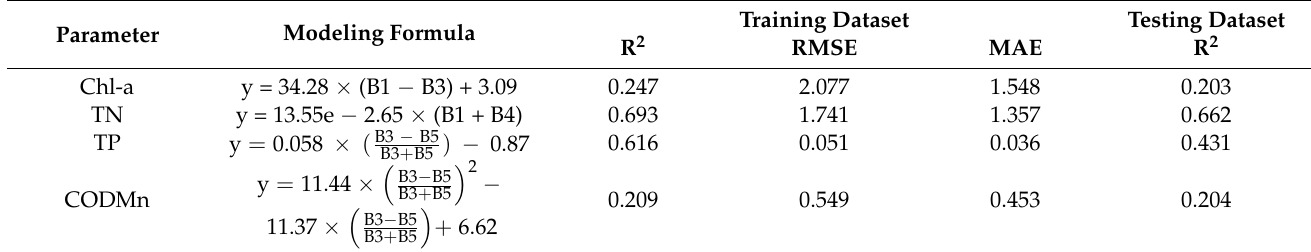
Table 6. Simple optimal single-variable regression model for each water quality